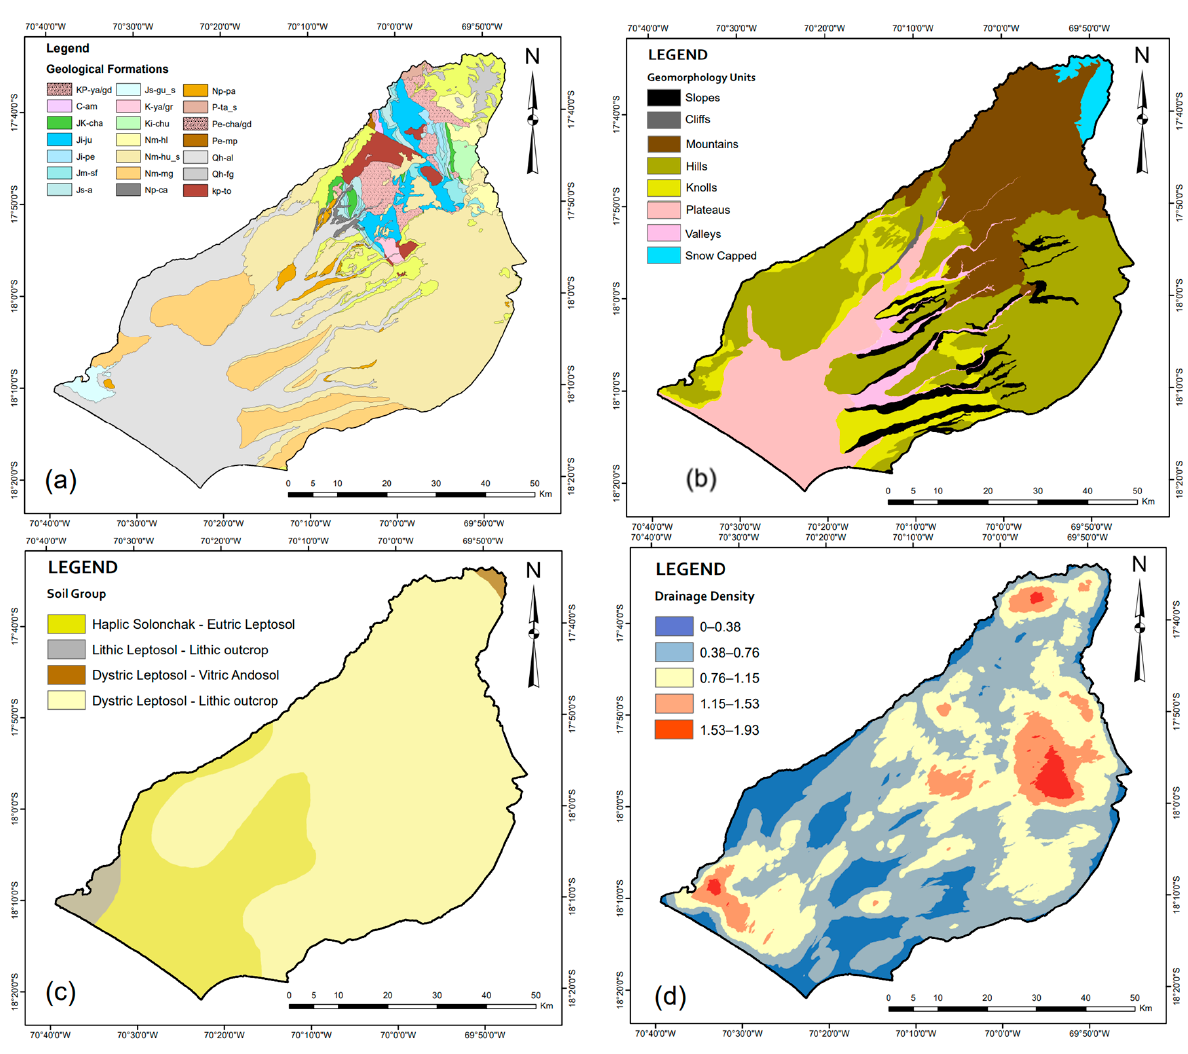
Figure 3. ( a ) Geology, ( b ) geomorphology, ( c ) soil, and ( d ) drainage density